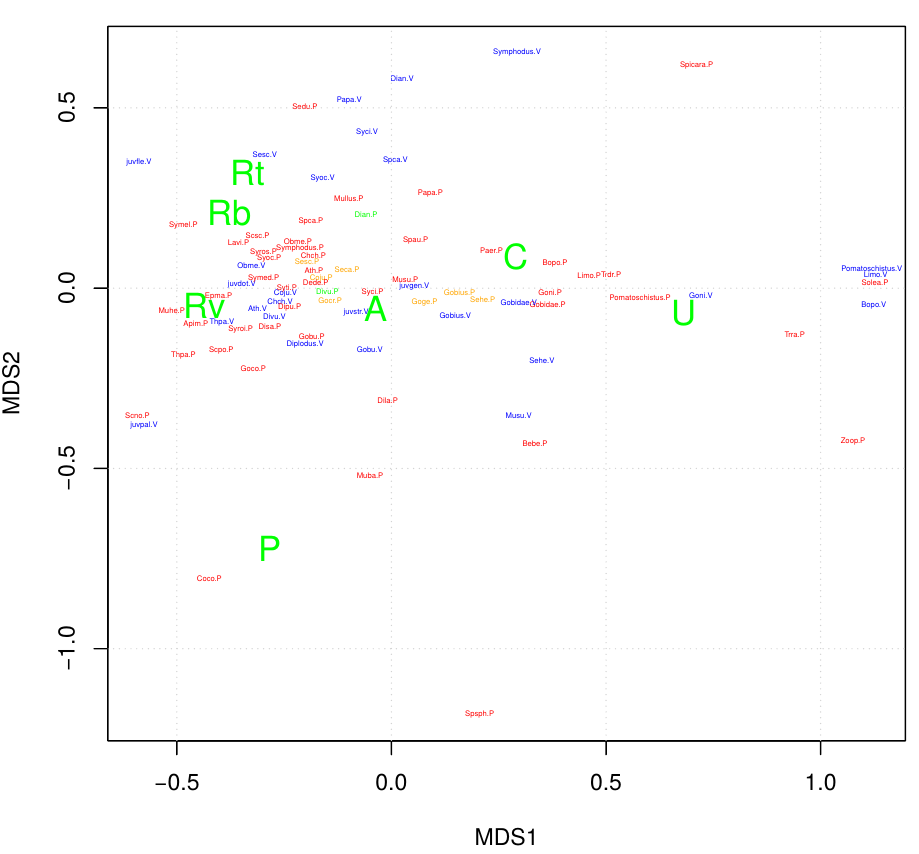
Figure 4. NMDS ordination of taxon relative habitat abundance. Red: piscivorous predators greater than 5 cm in length. Blue: prey taxa, all individuals under 5 cm in length. Orange: aggressive predators, wait-chasers. Green: aggressive predators, cruise-chasers. See Table 2 for Latin binomials. Rb, Rt, Rv: bare rock, rock covered with algal turf, and rock covered with macroalgae respectively. U: unconsolidated sediment. A: macroalgae (usually Cystoseira spp.). P: seagrass Posidonia oceanica . C: seagrass Cymodocea nodosa